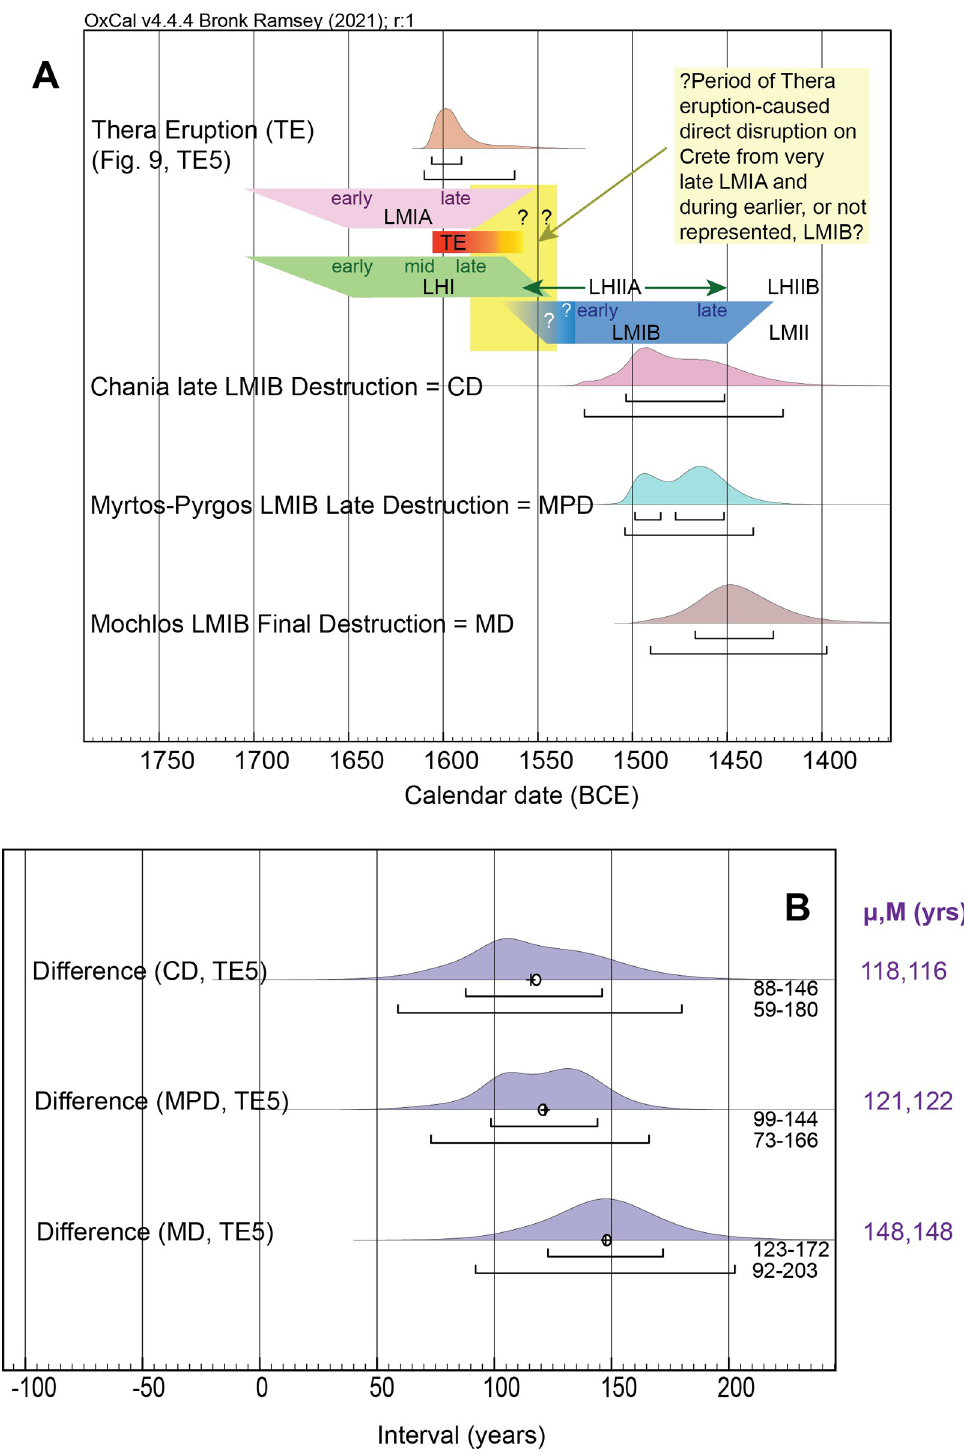
Fig 11. Comparison of the calendar date ranges for the close of LMIB destructions at three sites on Crete versus the Thera eruption (TE, or TE5 = stage v) and the time interval in-between. ( A ) The modelled posterior probability for the Thera eruption (Fig 9) compared with the modelled posterior probabilities for the close of LMIB destructions at Chania, Myrtos-Pyrgos and Mochlos on Crete (Fig 10). Possible archaeological period relationships are indicated along with the suggestion of a potentially important absence of evidence in the earlier-mid 16 th century BCE from very late